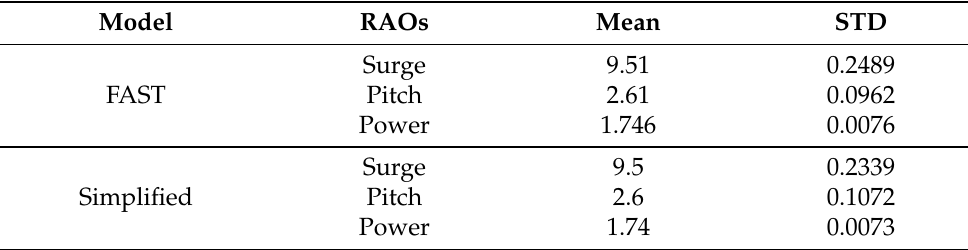
Figure 17. Output power of the spar-buoy floating turbine under irregular wave and wind speeds of 8 m/s. Table 4. Mean and standard deviation of RAO motions and output power for the spar-buoy turbine